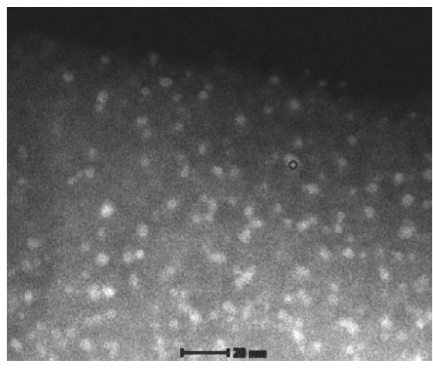
Figure 2: Transmission electron microscopy image of silver nano- patches in the center of a ceramic tablet using scanning electron microscopy mode. The scale bar represents 20nm in length [21].